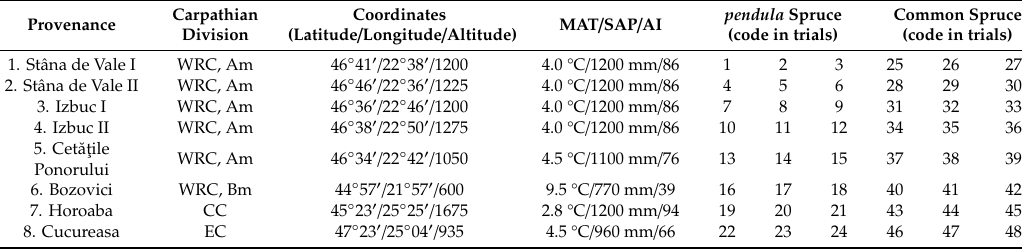
Figure 1. The locations of the field trials and provenances’ origin. Table 1. The location and climatic conditions of the provenances origin place.